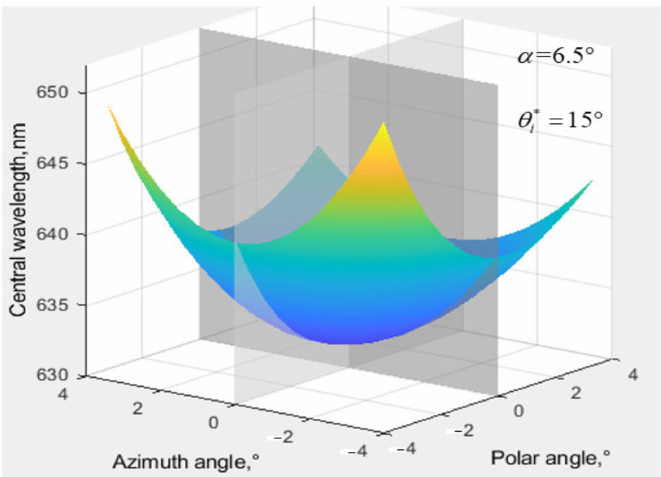
Figure 3. Central wavelength shift at ± 4 ◦ angle of incident light.